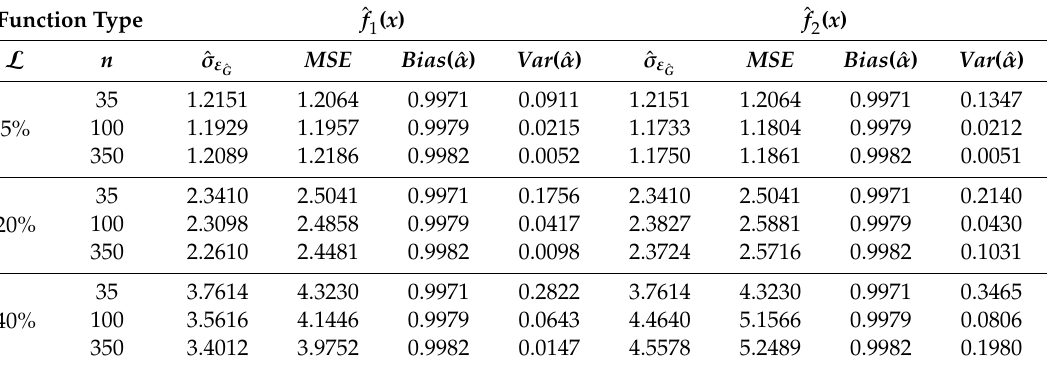
Table 2. Variances and biases of ˆ α , variance of the model simulation combinations.